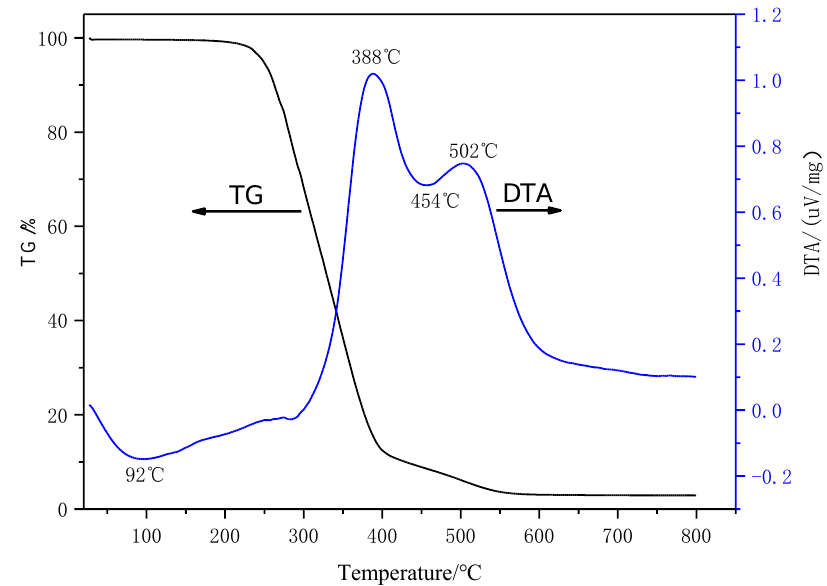
Figure 5. DTA/TG analysis of low temperature flower